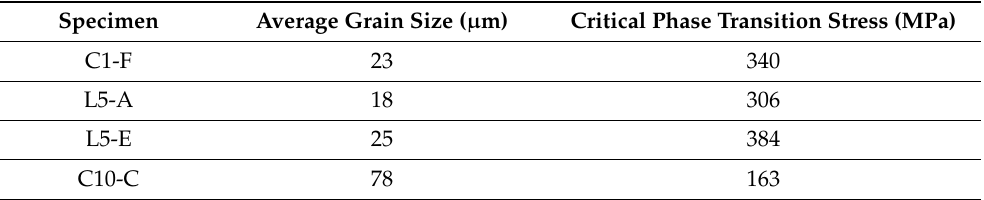
Table 2. Average grain size and critical phase transition stress of selected analyzed struts produced via C-type and L-type scanning strategies.